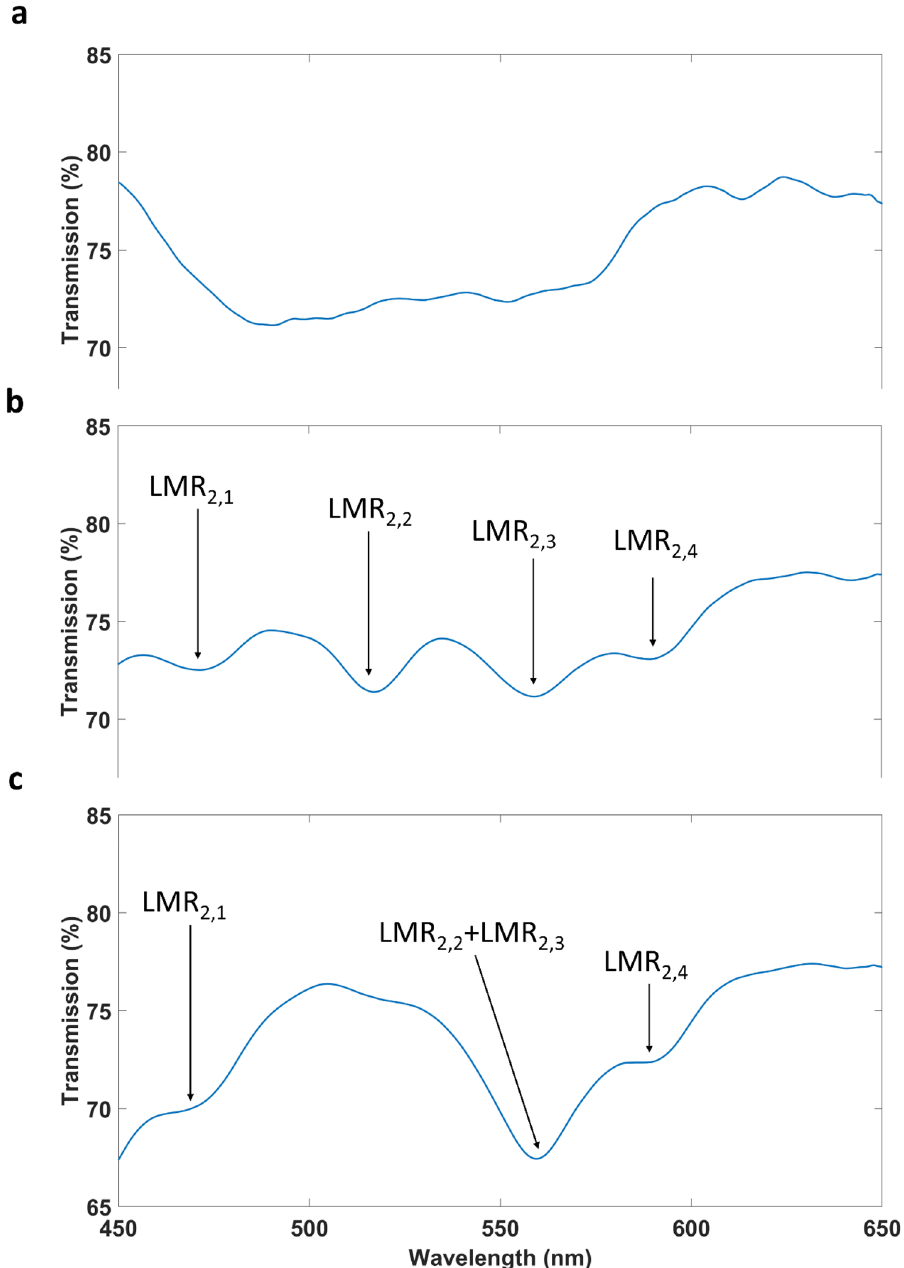
Figure 3. LMRs generated with device 1. HCl was used to separate four different regions of the coating: (a) LMRs when the all the four regions are surrounded by air (RI = 1); (b) LMRs when the all the four regions are surrounded by water (RI = 1.33); (c) LMRs when the all the regions are surrounded by air except for region 2, which is surrounded by